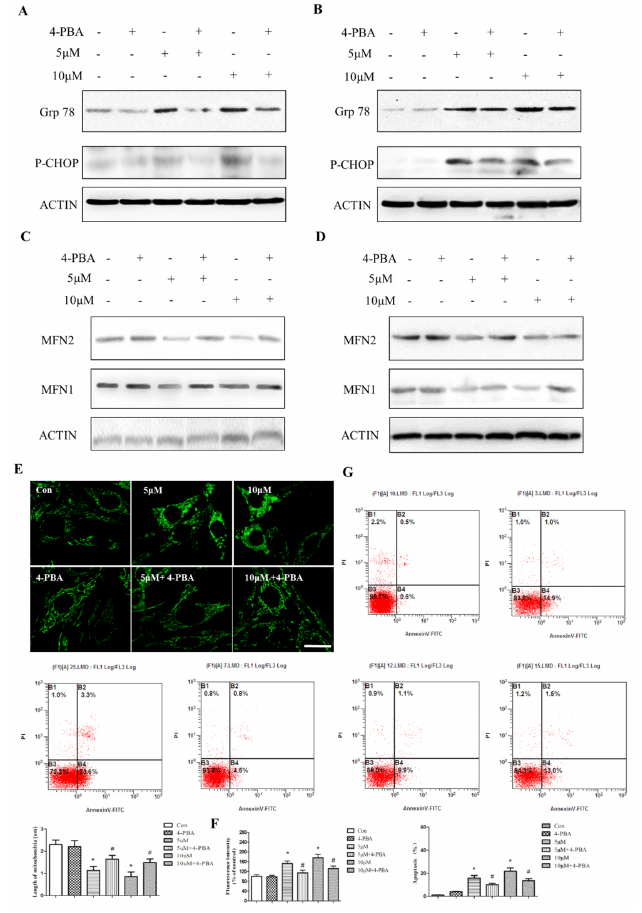
Figure 5. Induction of ER stress is required for mitochondrial dysfunction. PC12 cells were pretreated with 4-PBA (5 mM), an inhibitor of ER stress, and then exposed to Pb. Protein expression of ER